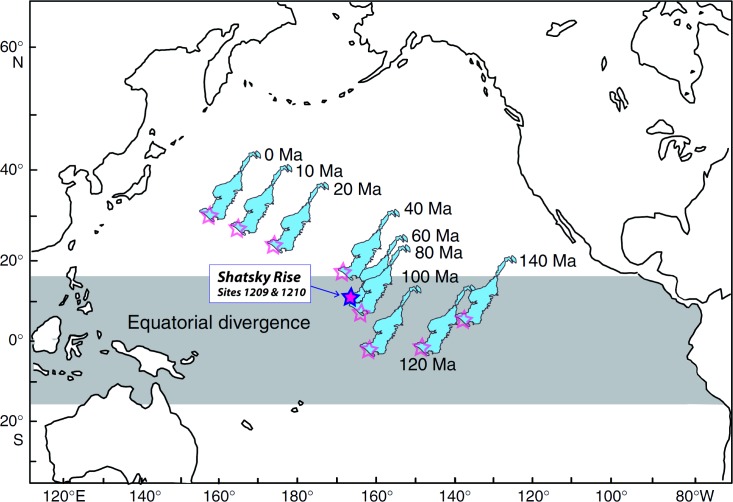
Pacific centered map of the Shatsky Rise (amended after [39]).ODP Sites 1209 and 1210 are marked by purple stars. Due to plate tectonic movements, the Shatsky Rise Plateau shifted north-westwards over the last 140 Myr. The blue framed star shows the studied site during the middle Paleocene (~60 Ma).